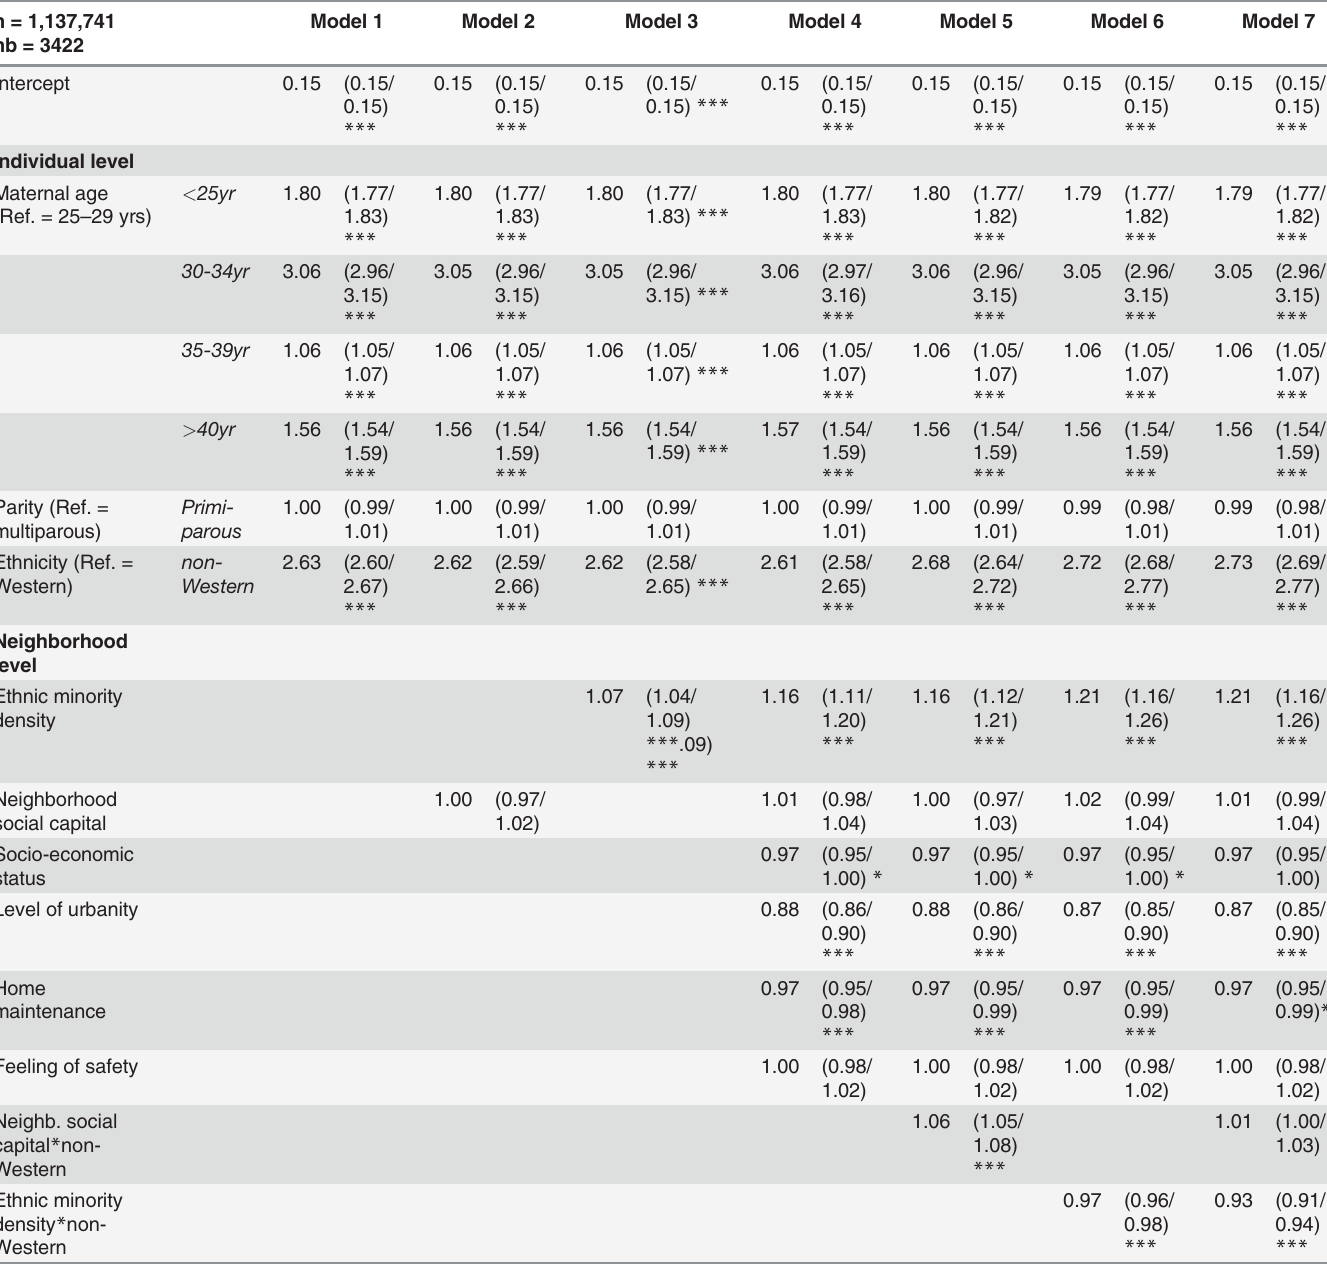
Table 4. Multilevel logistic regression models of ethnic minority density and other individual and neighborhood characteristics on late entry into care (after 14 weeks of gestation). n = 1,137,741 nb =